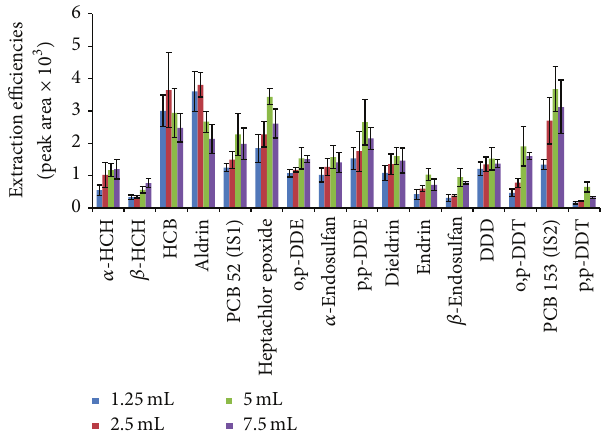
Figure 5: Effect of amount of water added to sample on extraction efficiencies of organochlorine